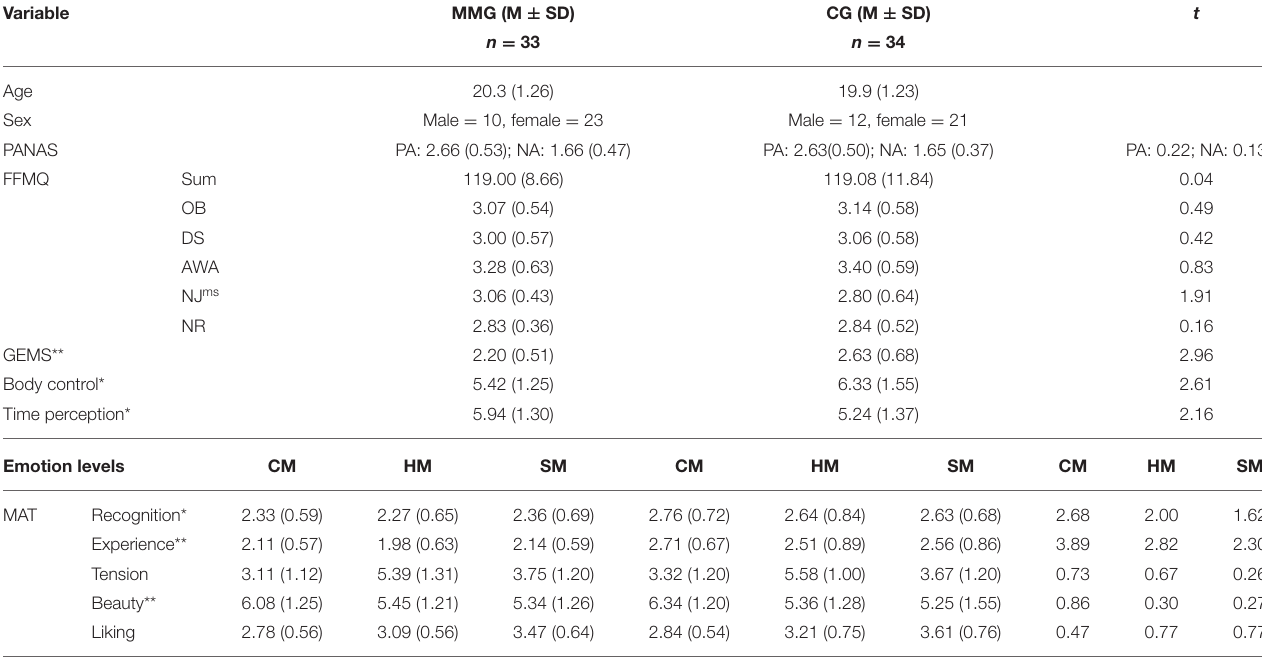
TABLE 1 | Demographic information and self-report results of the participants.